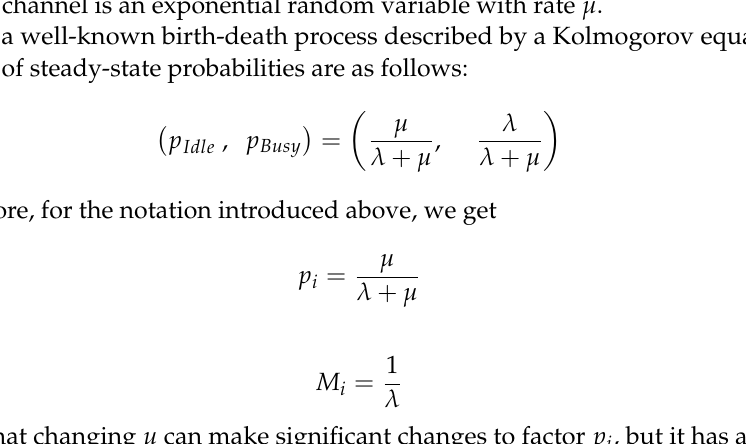
Figure 5. Markov model for a licensed channel’s status.